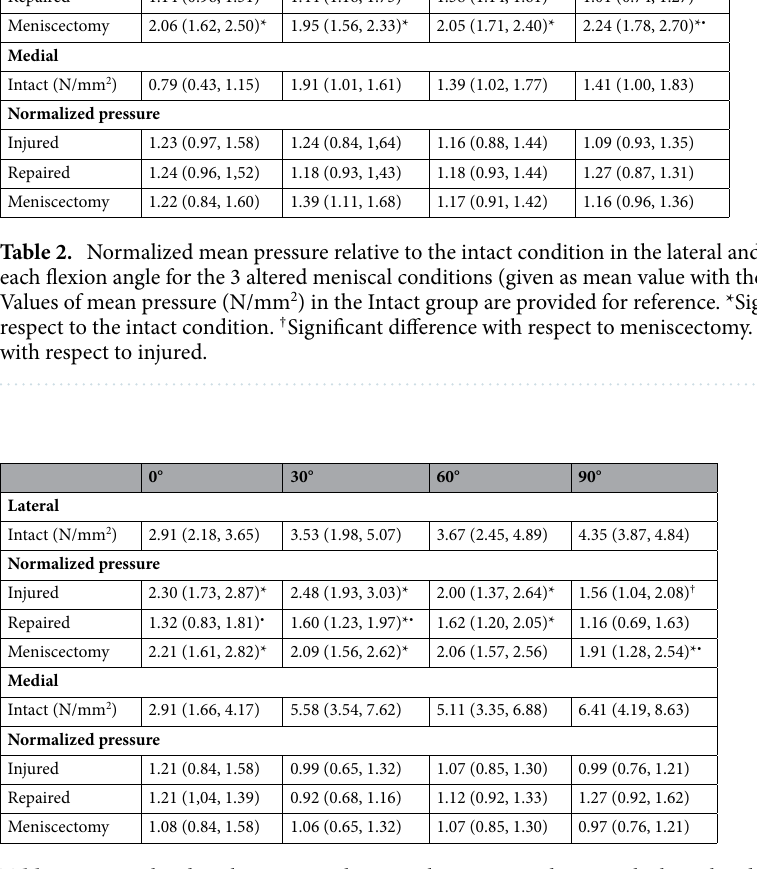
In the medial condyle (Table 2), no statistical differences between tested conditions were detected. Normalized peak pressure. In the lateral condyle (Table 3, Fig. 4c), the injury produced a significant increase in the peak pressure compared to the intact group for all flexion angles except 90° (p = 0.018 at 0°, p = 0.017 at 30°, and p = 0.012 at 60°). The alteration was again more pronounced in extension than at high flex- ion. As for previous parameters, meniscectomy significantly altered peak pressure (p = 0.018 at 0°, p = 0.017 at 30°, p = 0.018 at 60°, p = 0.028 at 90°) but without a particularly greater influence at low flexion. Furthermore, significant differences between the injured and meniscectomy groups were found only at 90° (p = 0.018). After repair, the mean normalized peak pressure decreased, reaching a level closer to the intact condition values, with significant differences found at 30° (p = 0.017) and 60° (p = 0.025) when comparing the intact and repaired groups. Decreases from the injured to the repaired condition reached 43% at extension, 35% at 30°, 19% at 60°, and 26% at 90°, with significant differences when the lesion was of more influence at 0° (p = 0.018) and 30° (p = 0.025). In the medial condyle (Table 3), no statistical differences were found between the tested conditions.